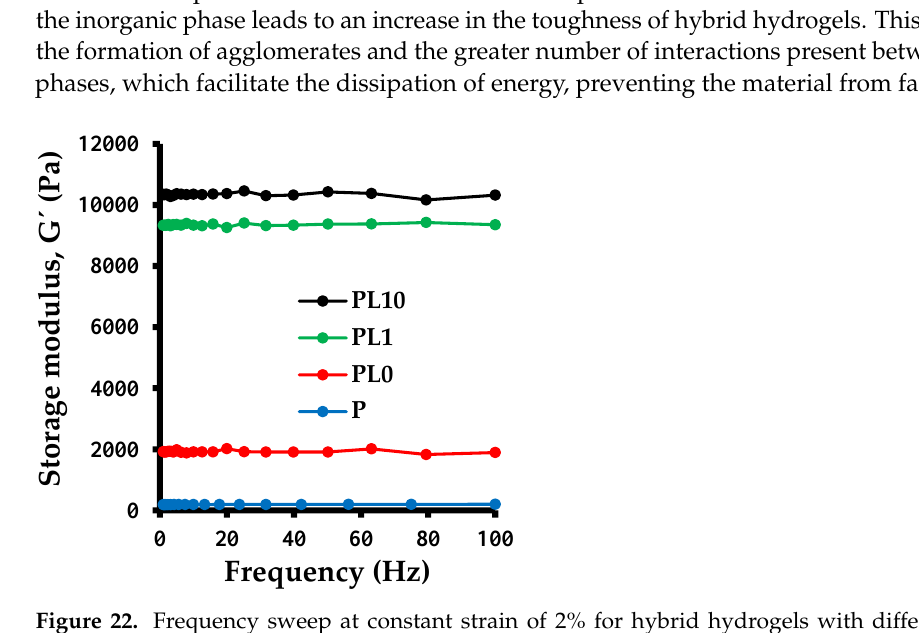
content of the inorganic phase. The modulus of elasticity is a measure of the stiffness of